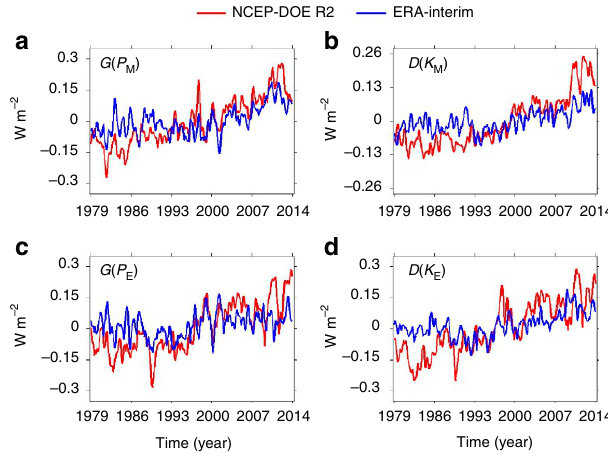
Figure 3 | Time series of the global-average generation and dissipation rates. ( a ) The generation rate of the mean available potential energy G ( P M ). ( b ) The dissipation rate of the mean kinetic energy D ( K M ). ( c ) The generation rate of the eddy available potential energy G ( P E ). ( d ) The dissipation rate of the eddy kinetic energy D ( K E